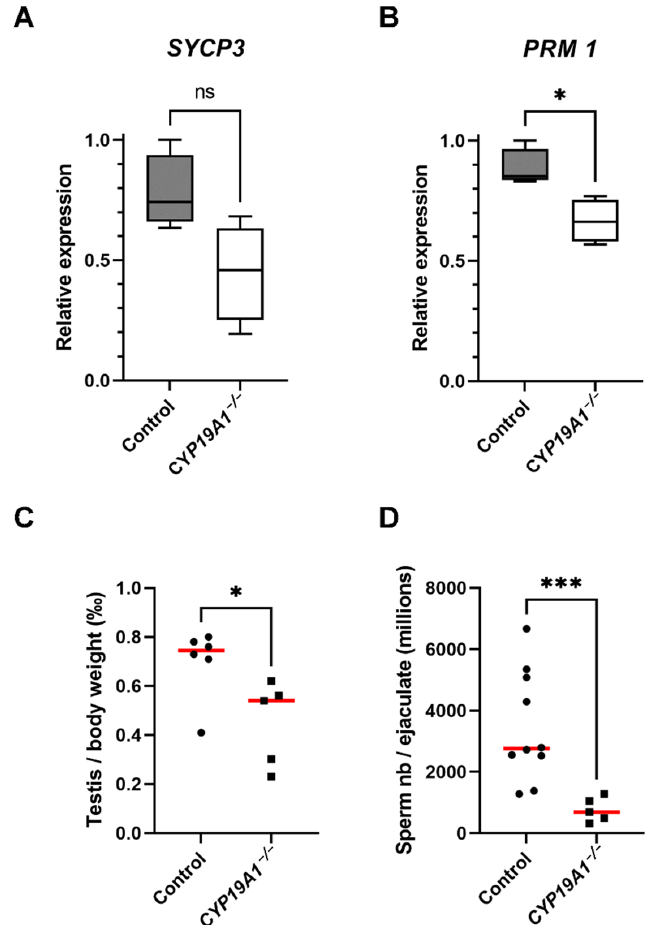
Figure 5. Hypo-spermatogenesis in CYP19A1 − / − males. ( A , B ) RT-qPCR analyses of mRNA levels of SYCP3 and PRM1 in control and CYP19A1 − / − adult testis (n = 5 for each genotype). ( C ) Testis on body weight ratio in control and CYP19A1 − / − rabbits. Control, n = 6; CYP19A1 − / − n = 5. The median is shown in red. ( D ) Total sperm counts per million per ejaculated sample in control and CYP19A1 − / − rabbits. Control, n = 10; CYP19A1 − / − n = 5. Dots represent the average of two successive semen collections per animal. For CYP19A1 − / − rabbits, three sets of two successive ejaculations were collected over a one ‐ year interval. The median is shown in red. Mann–Whitney test: * p ‐ value < 0.05. *** p ‐ Value < 0.0005. ns: non ‐ significant.